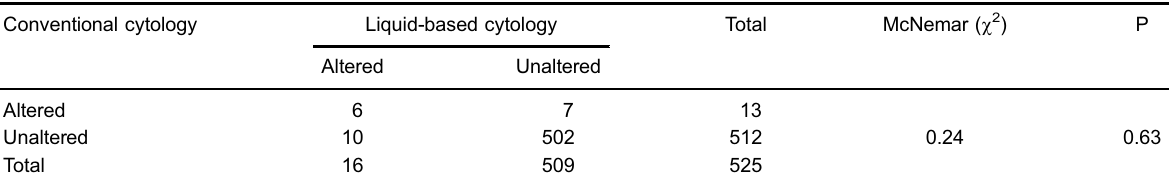
Altered/positive: ASCUS/ASC-H/LSIL/HSIL/CA in situ . ASCUS: atypical squamous cells of undetermined signi fi cance; ASCH: atypical squamous cells without high-grade lesion; LSIL/HSIL/CA: low-grade squamous intraepithelial lesion/high-grade squamous intraepithelial lesion/cervical